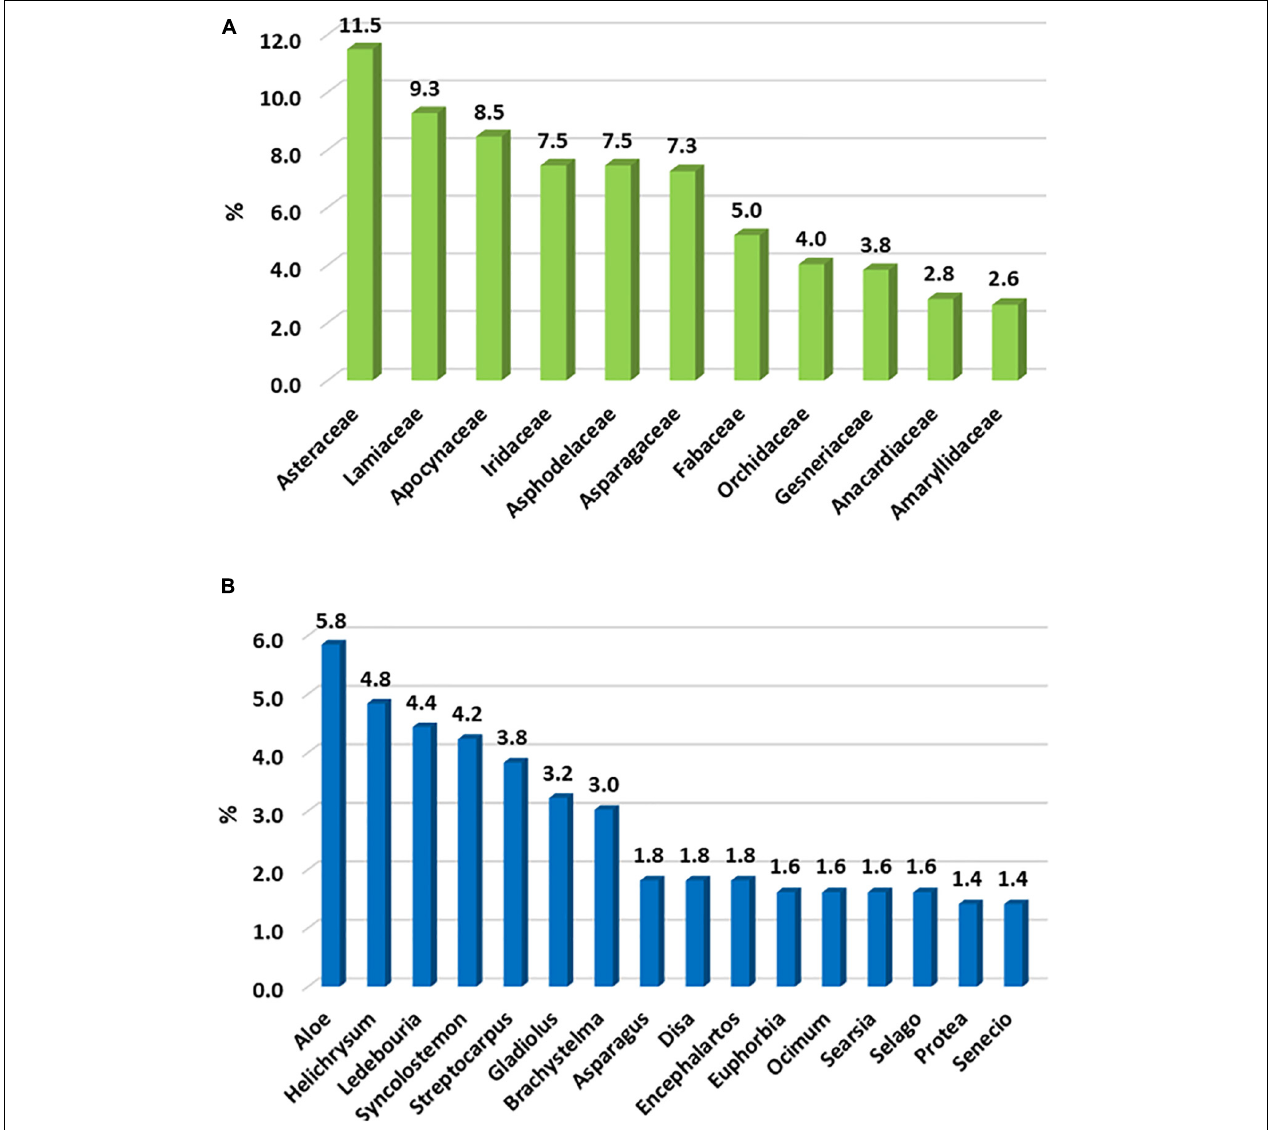
FIGURE 3 | The top ten (A) families and (B) genera hosting the most endemic plant taxa in the Limpopo–Mpumalanga–Eswatini Escarpment (LMEE); we include shared results, resulting in 11 families and 16 genera holding the top ten